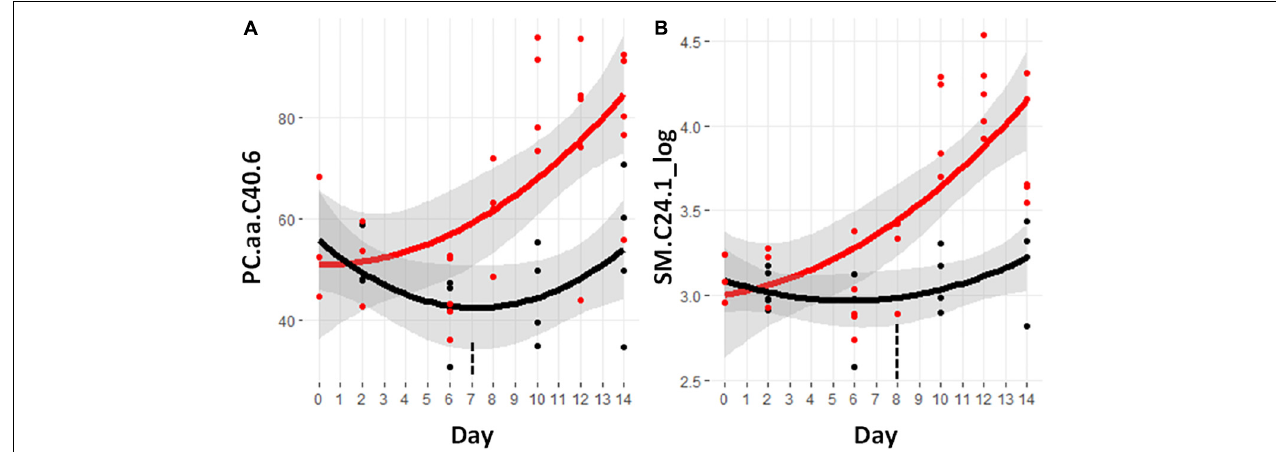
FIGURE 6 | Trajectory of lipid measurements that were statistically significantly different prior to the significant weight loss at day 9. (A) PC.aa.C40.6, phosphocholine with a total of 40 carbons in the two fatty acid side chains attached by ester bonds and having six sites of unsaturation. (B) SM.C24.1, sphingomyelin containing a fatty acid containing 24 carbons and one site of unsaturation. Black indicates control mice, red indicates cachectic mice, and the vertical dashed lines indicate the day in which the data were first significantly different.